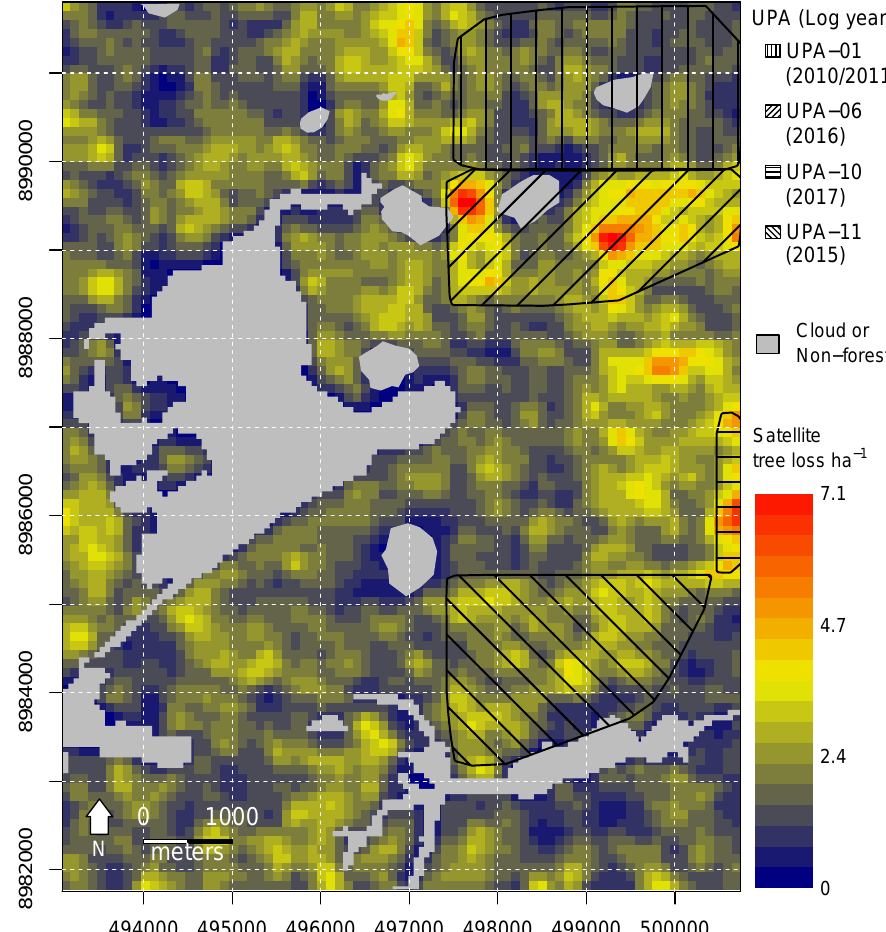
Figure 8. Satellite-based tree loss map during 2014–2017 for a section of 76.6 km 2 inside the Jamari National Forest (UTM, datum WGS-84). The background corresponds to the isotropic kernel-smooth density of satellite-based tree losses per hectare. Black lines are the boundaries of the